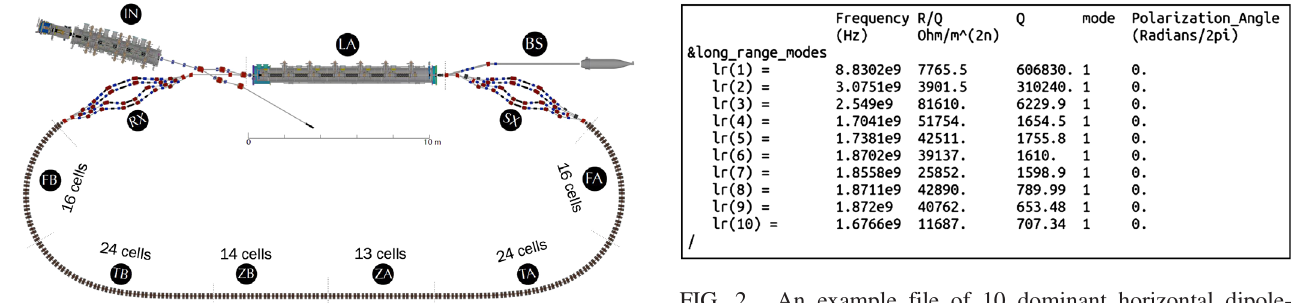
FIG. 1. Layout of CBETA. The sections labeled (IN) and (LA) are the injector and MLC cavities respectively. Sections (FA), (TA), (ZA), (ZB), (TB), and (FB) form the FFA beamline which can accommodate four recirculating orbits with energy ranging from 42 MeV to 150 MeV. Sections (SX) and (RX) are splitters and recombiners which control the path-length of each recircu- lation pass.